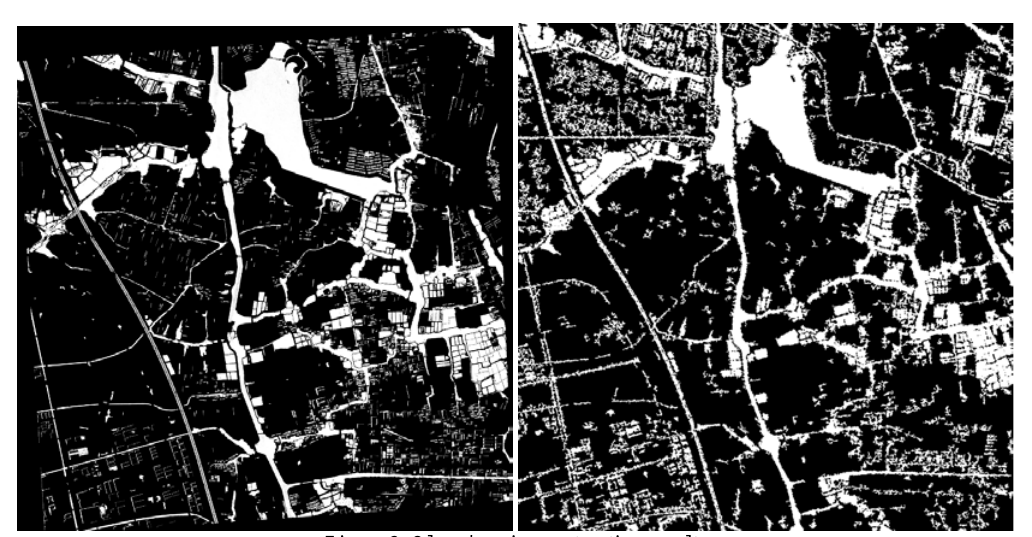
Figure 1. The original optical and SAR images